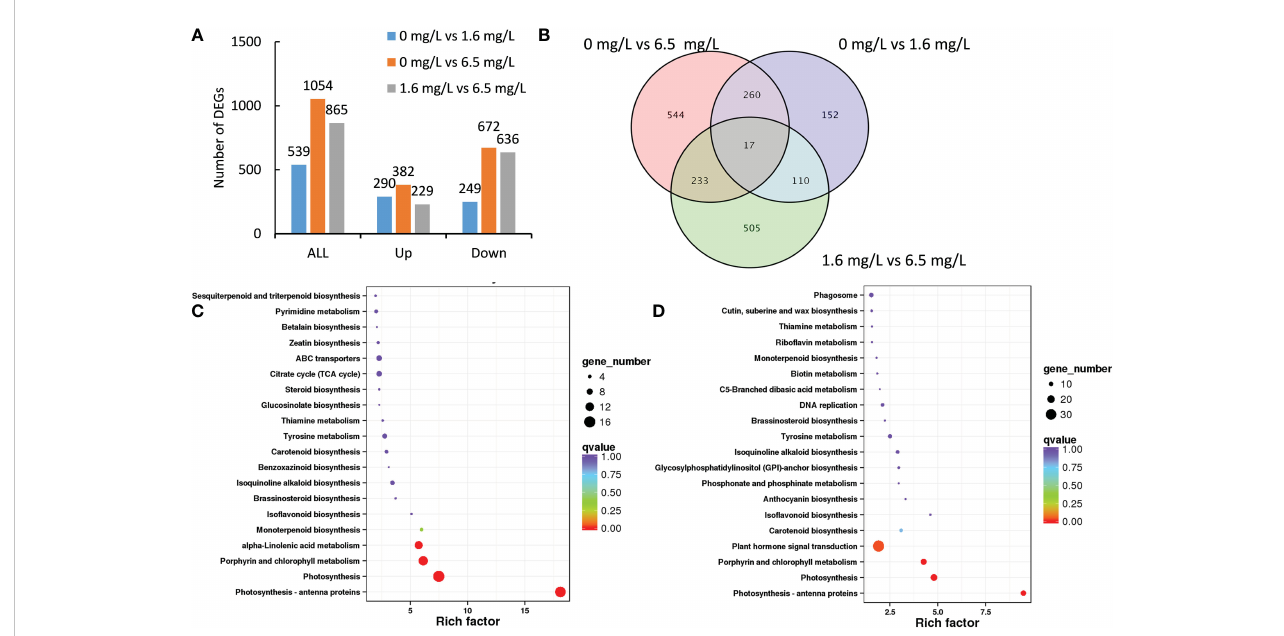
FIGURE 3 Transcriptomic pro fi les of peppermint leaf in response to low (1.6 mg L -1 ) and high (6.5 mg L -1 ) levels of Cd stress treatments at 72 h. (A) , the number of up- or down-regulated differentially expressed genes (DEGs); (B) , the venn diagram of DEGs; (C) , KEGG enrichment pathway of DEGs from the comparison of 0 mg L -1 Cd treatment vs 1.6 mg L -1 Cd treatment; (D) , KEGG enrichment pathway of DEGs from the comparison of 0 mg L -1 Cd treatment vs 6.5 mg L -1 Cd